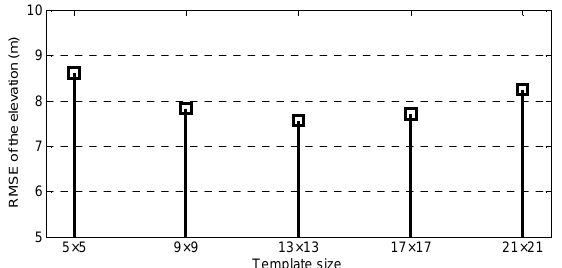
Figure 2. RMSE of the elevation according to the template size